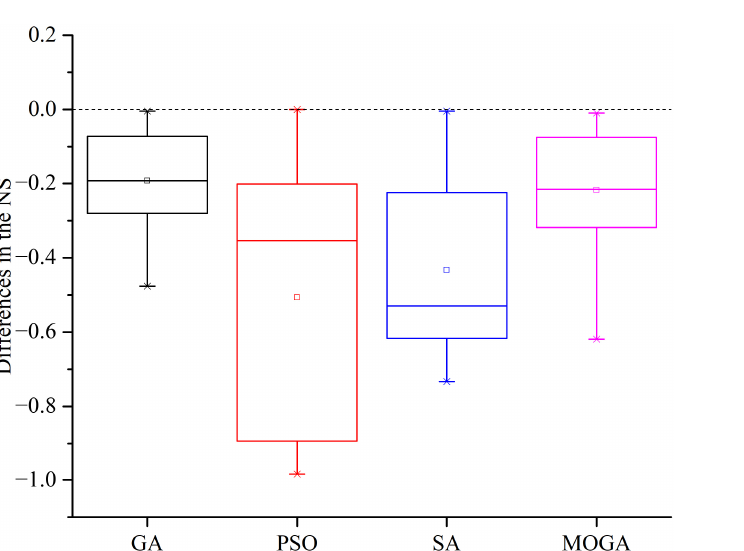
Figure 9. Illustration of the differences in the NS when the test algorithms use the optimal HPSs and the default ones.